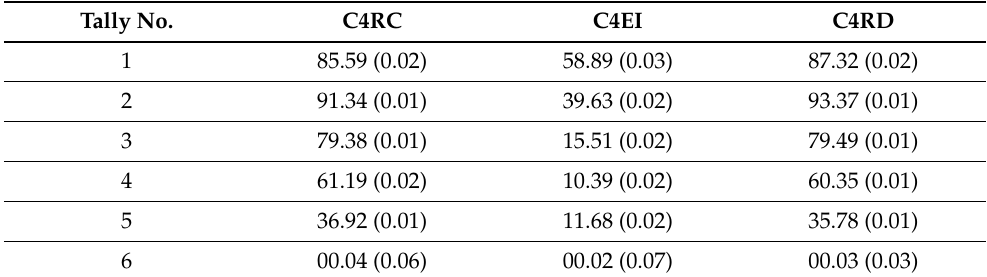
Table 3. SDDR [ µ Sv/h] (MCNP relative error) at 12 days following Short scenario. Tally